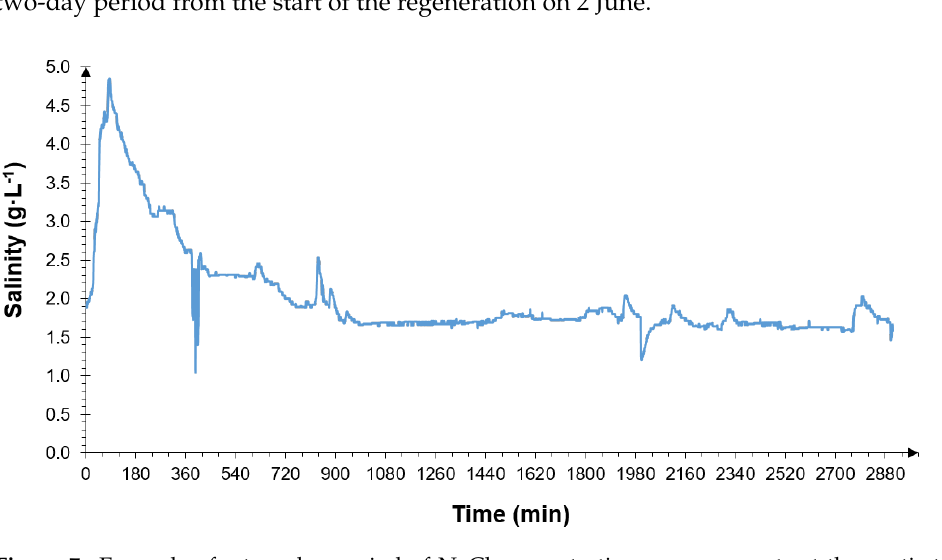
Figure 7. Example of a two-day period of NaCl concentration measurements at the septic tank outflow, after the start of water softener regeneration.